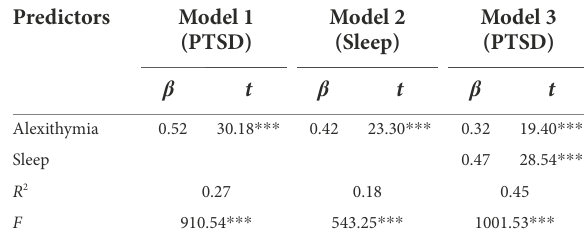
TABLE 3 Mediation effect of alexithymia on PTSD ( N =